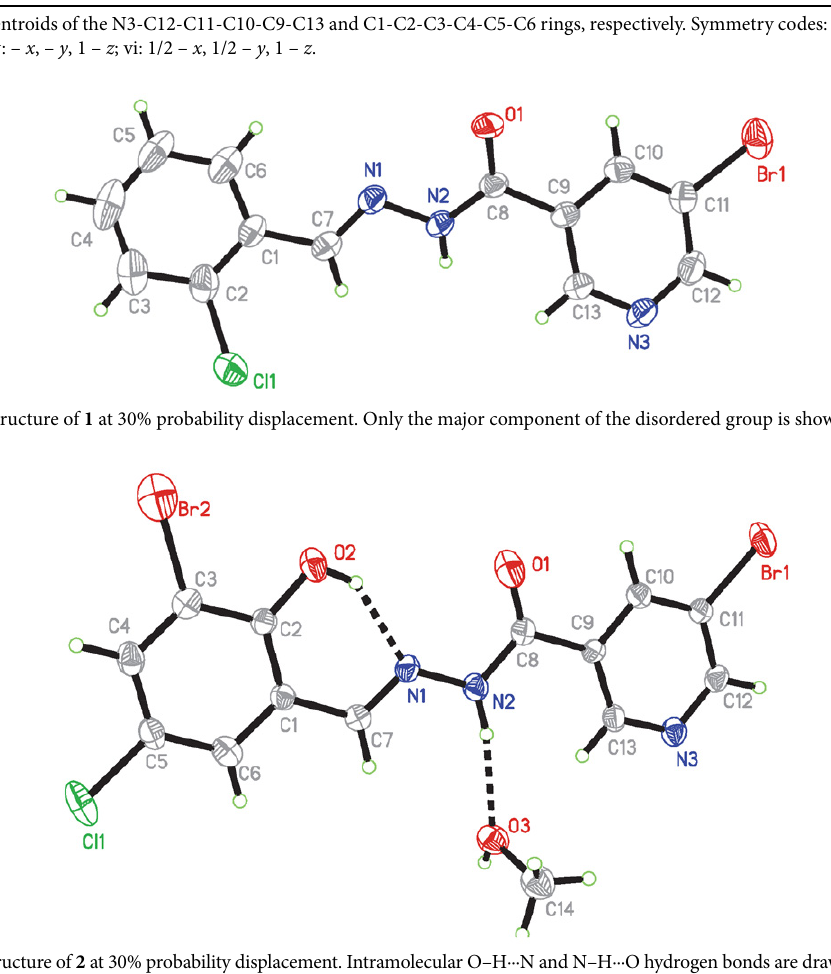
Figure 2. Molecular structure of 2 at 30% probability displacement. Intramolecular O–H···N and N–H···O hydrogen bonds are drawn as dashed